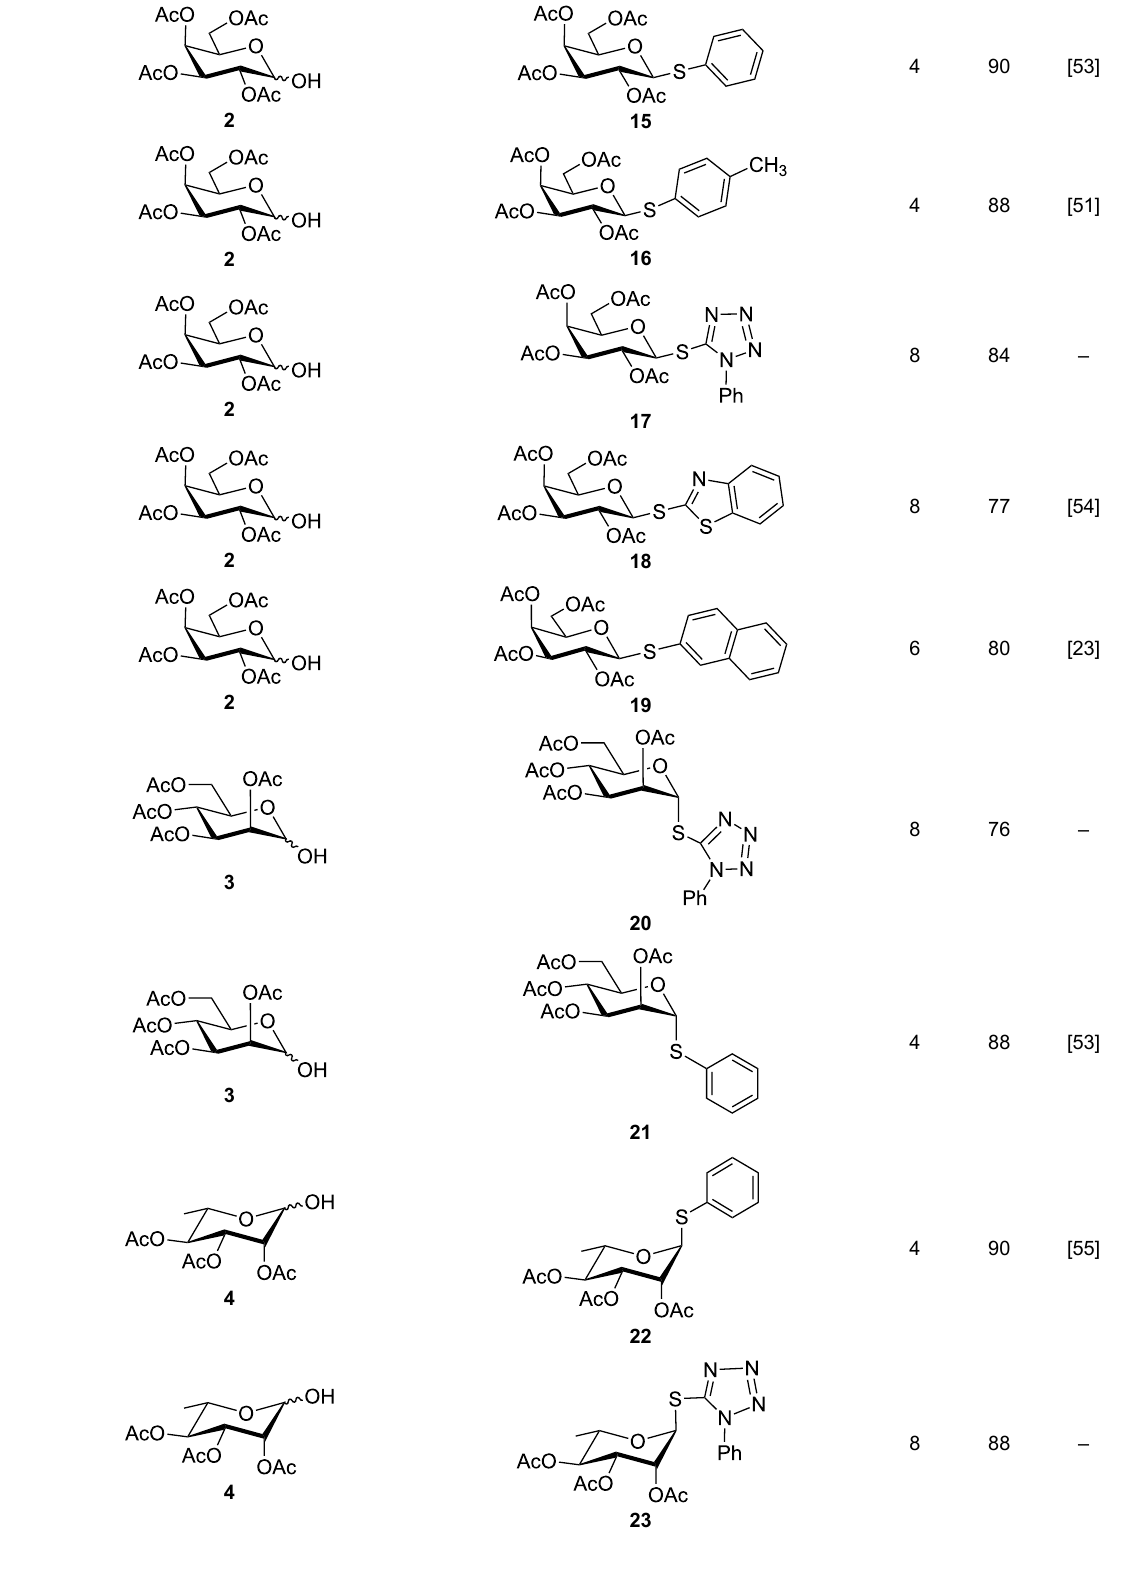
Table 3: Appel-reagent-mediated transformation of glycosyl hemiacetal derivatives to the thioglycosides at room temperature. (continued)